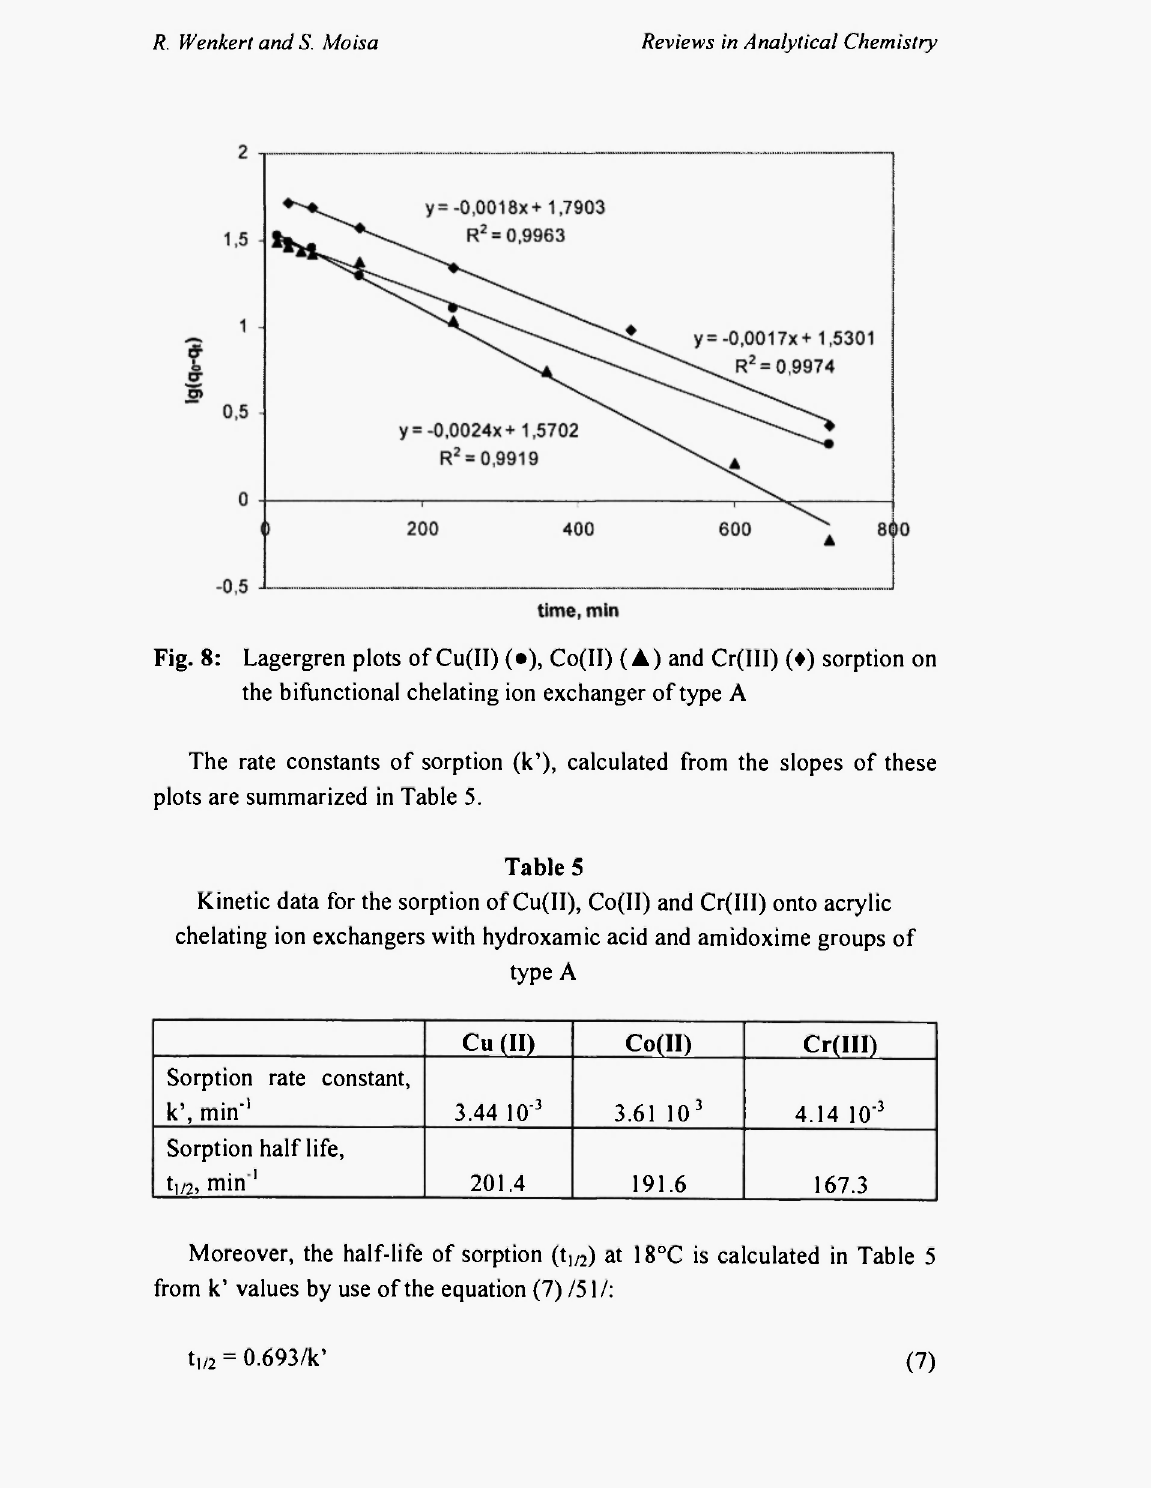
Kinetic data for the sorption of Cu(II), Co(II) and Cr(III) onto